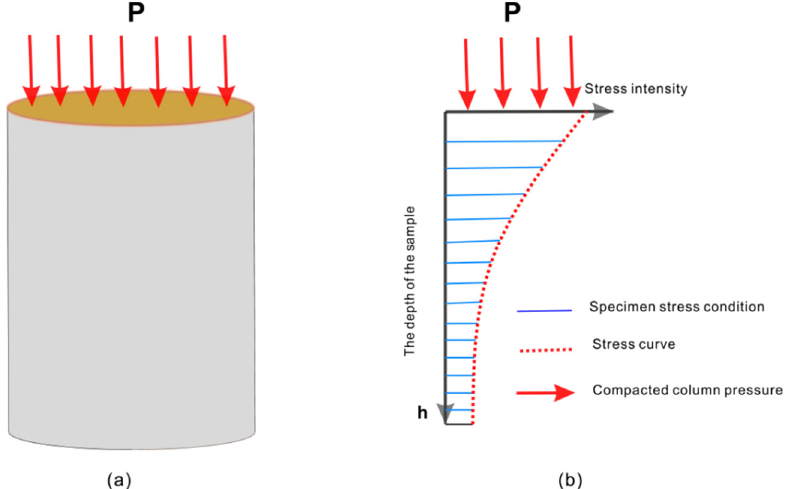
Figure 5. Stress distribution diagram: ( a ) the stress acting on the sample is averagely distributed; ( b ) schematic diagram of the internal stress of the specimen.